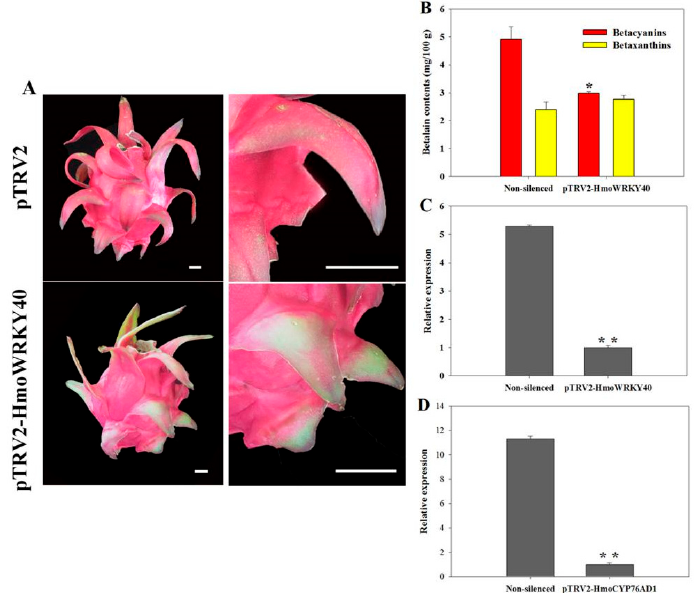
Figure 6. Silencing of HmoWRKY40 inhibits betalain production: ( A ) Virus-induced gene silencing of HmoWRKY40 in red scales. Bars = 2 cm, ( B ) Betalain contents in pitaya scales after virus-induced silencing of HmoWRKY40 (* indicates p < 0.05). Three independent experiments were conducted (n = 3). The error bars indicate one standard error, ( C ) RT-qPCR analyses of HmoWRKY40 in virus- induced gene silencing (VIGS) treatment scales. The expression level of pTRV2-HmoWRKY40 was used as the calibrator (set as 1). The data represent mean values from three biological replicates (±S.D.). ** indicates significant differences at p value < 0.01 using a two-tailed t -test and ( D ) RT- qPCR analyses of HmoCYP76AD1 in VIGS treatment scales. The expression level of pTRV2-